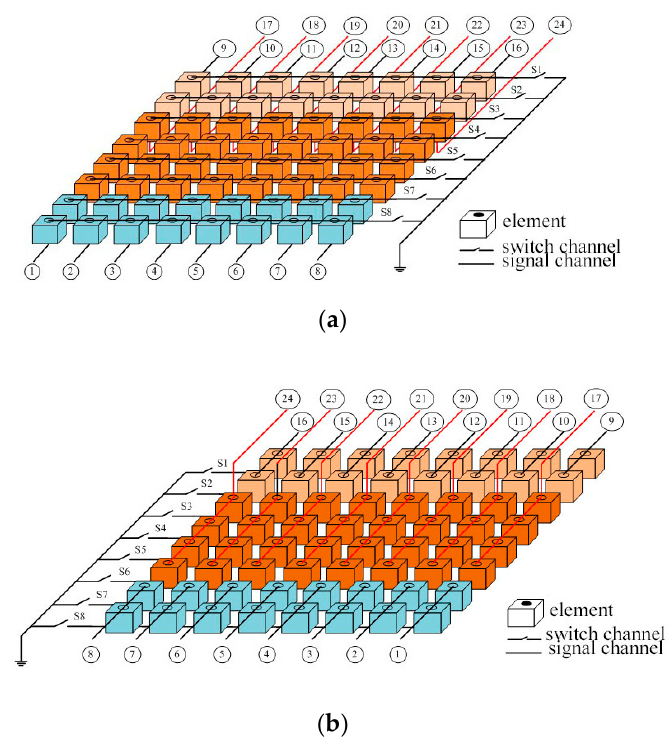
Figure 3. The split row-column addressing scheme for an 8 × 8 array, where the elements in signal channel direction are divided into three blocks: ( a ) obverse side and ( b ) reverse side.